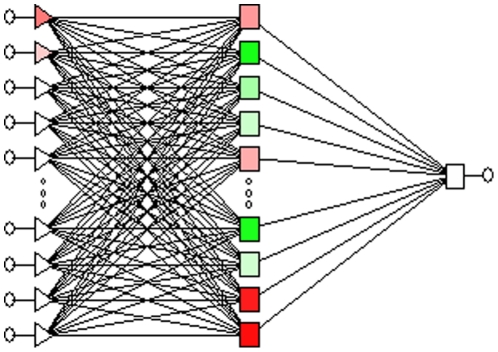
The Optimal Network Architecture of The Artificial Neural Network.A multilayer perceptron with 16 input nodes and 13 hidden nodes in the network.